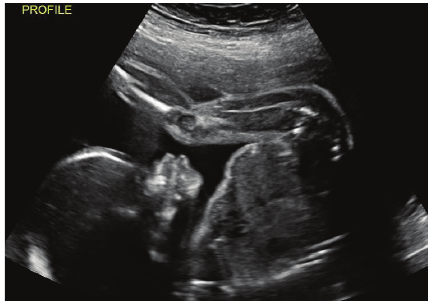
Figure 2: Anatomy assessment at 21-week gestation shows contin- ued flat facial profile with nasal hypoplasia.